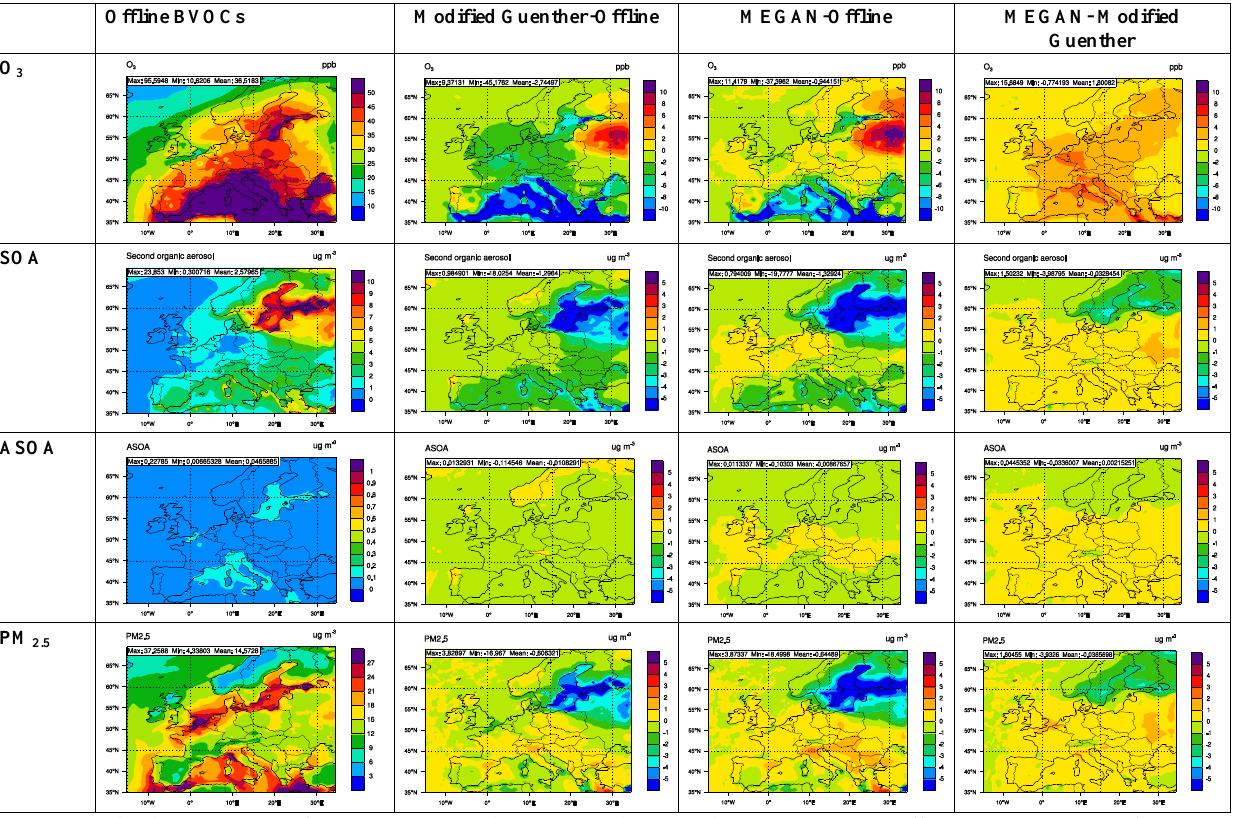
Figure 11. Simulated concentrations of O 3 , SOA, ASOA, and PM 2.5 species by WRF/Chem-MADRID using offline BVOCs emissions of Simpson et al. (1999) (Column 1) and the absolute differences in their concentrations between simulations with modified Guenther online module and offline emissions (Column 2), between simulations with MEGAN2 online module and offline emissions (Column 3), and between simulations with MEGAN2 and modified Guenther online modules (Column 4) in July 2001 over D01.